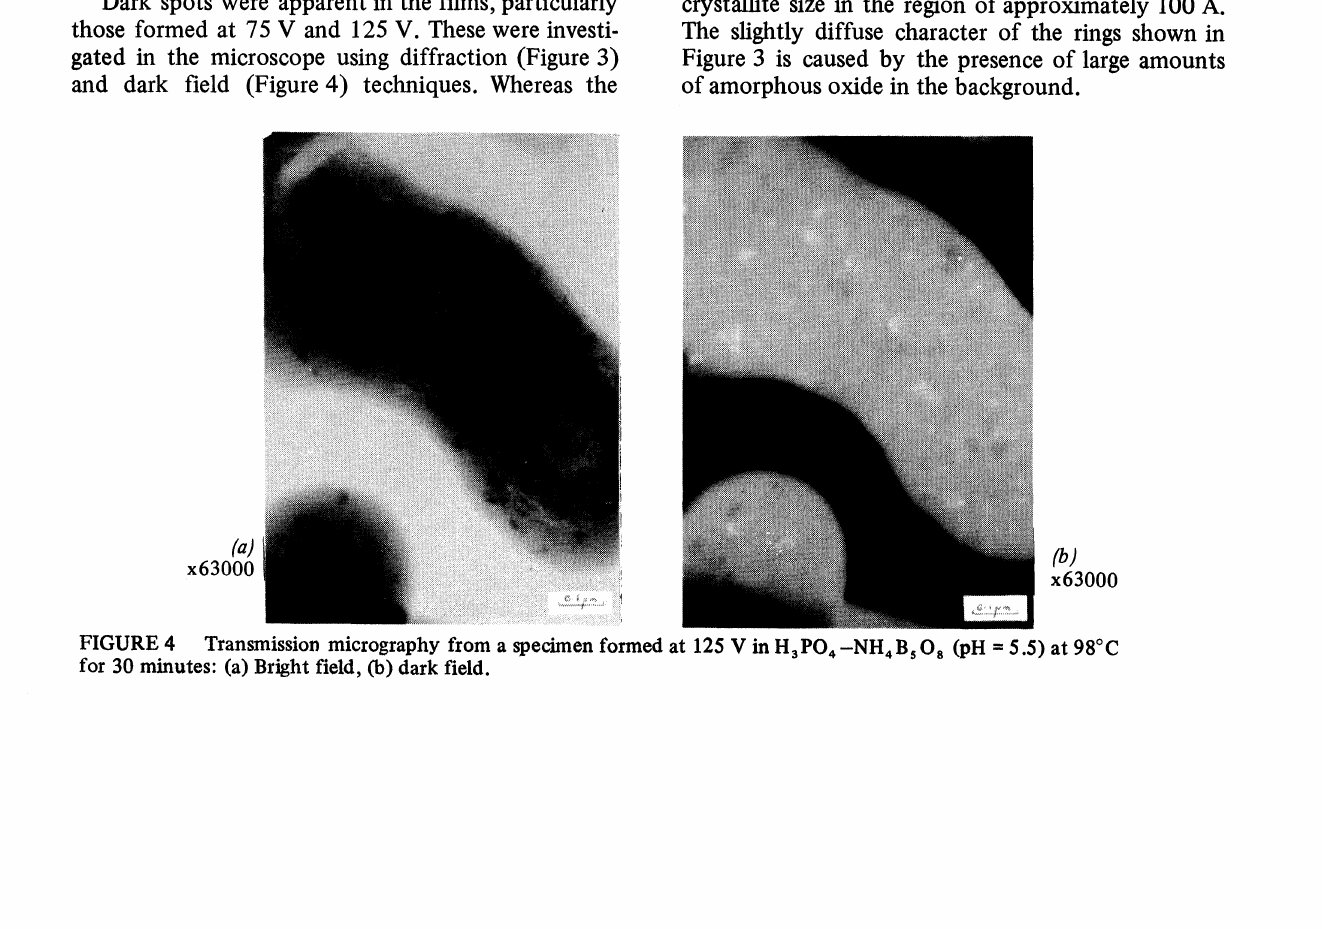
FIGURE 4 Transmission micrography from a specimen formed at 125 V in H PO4-NH4 B O8 (pH 5.5) at 98C for 30 minutes" (a) Bright field, (b) dark